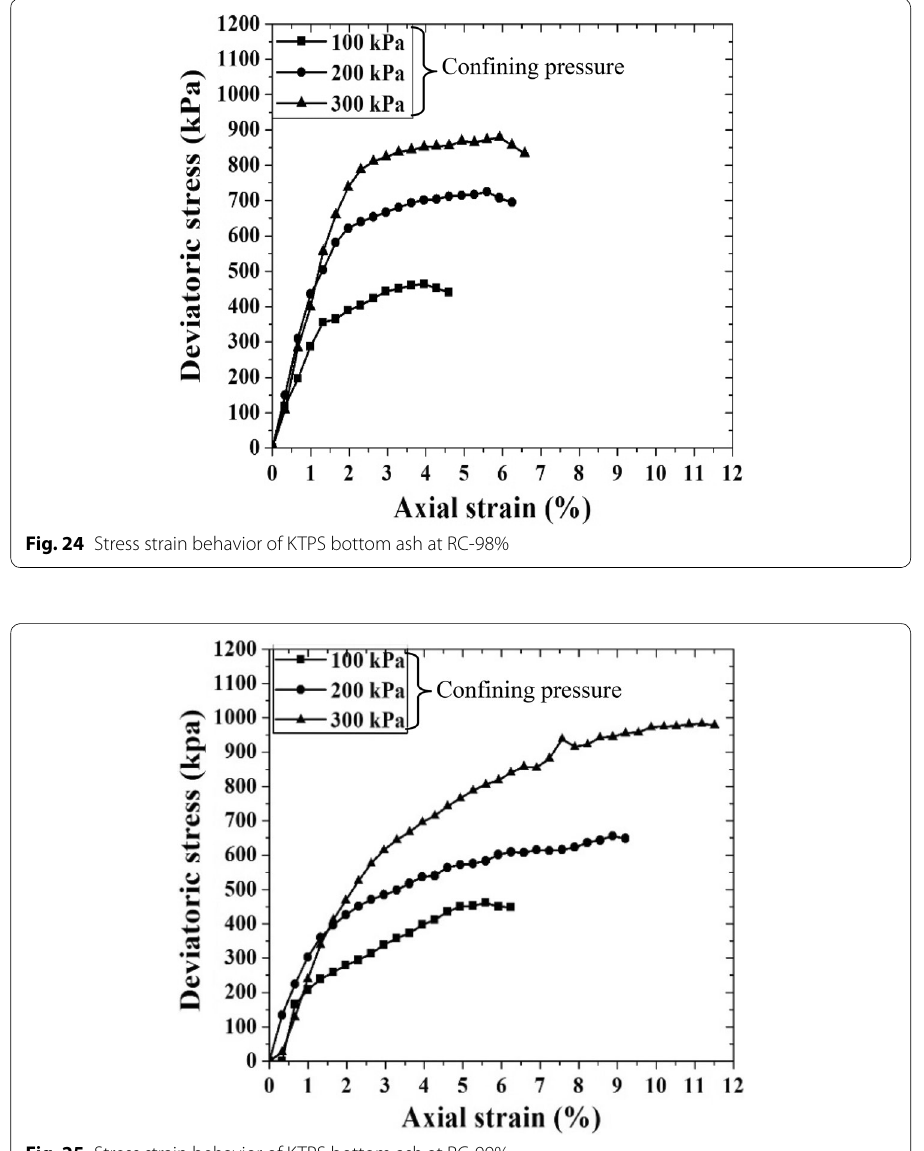
Fig. 25 Stress strain behavior of KTPS bottom ash at